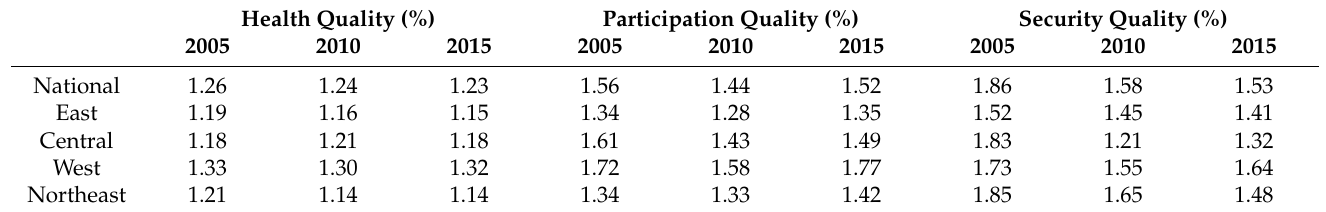
Table 2. The coefficient of variation of health, participation, and security quality of life for the oldest-old.